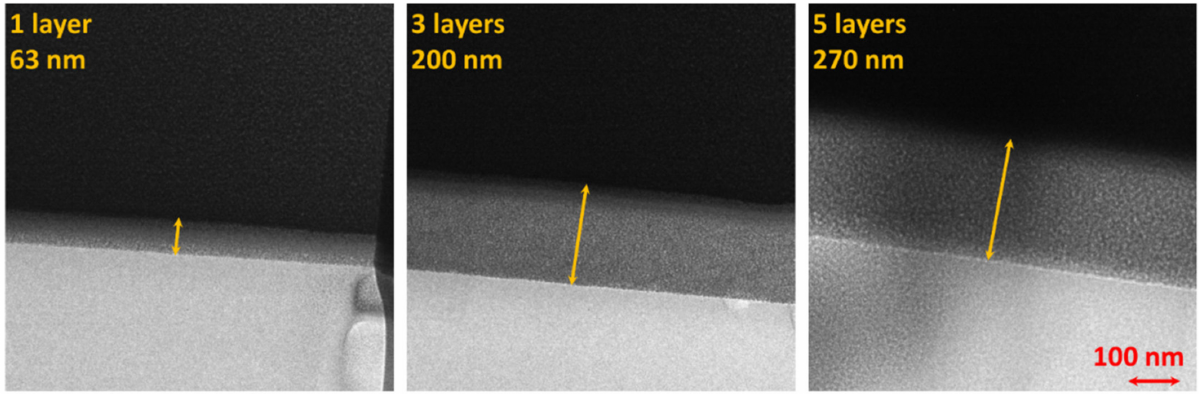
Figure 4. SEM images of the substrates before coating and with one, three, and five photocatalyst layers.